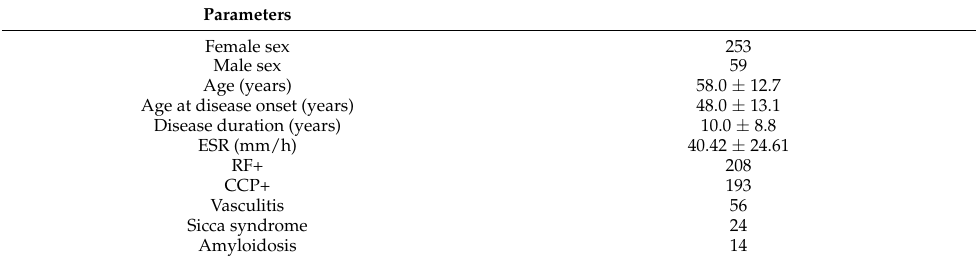
Table 1. Baseline clinical characteristics of patients with rheumatoid arthritis.